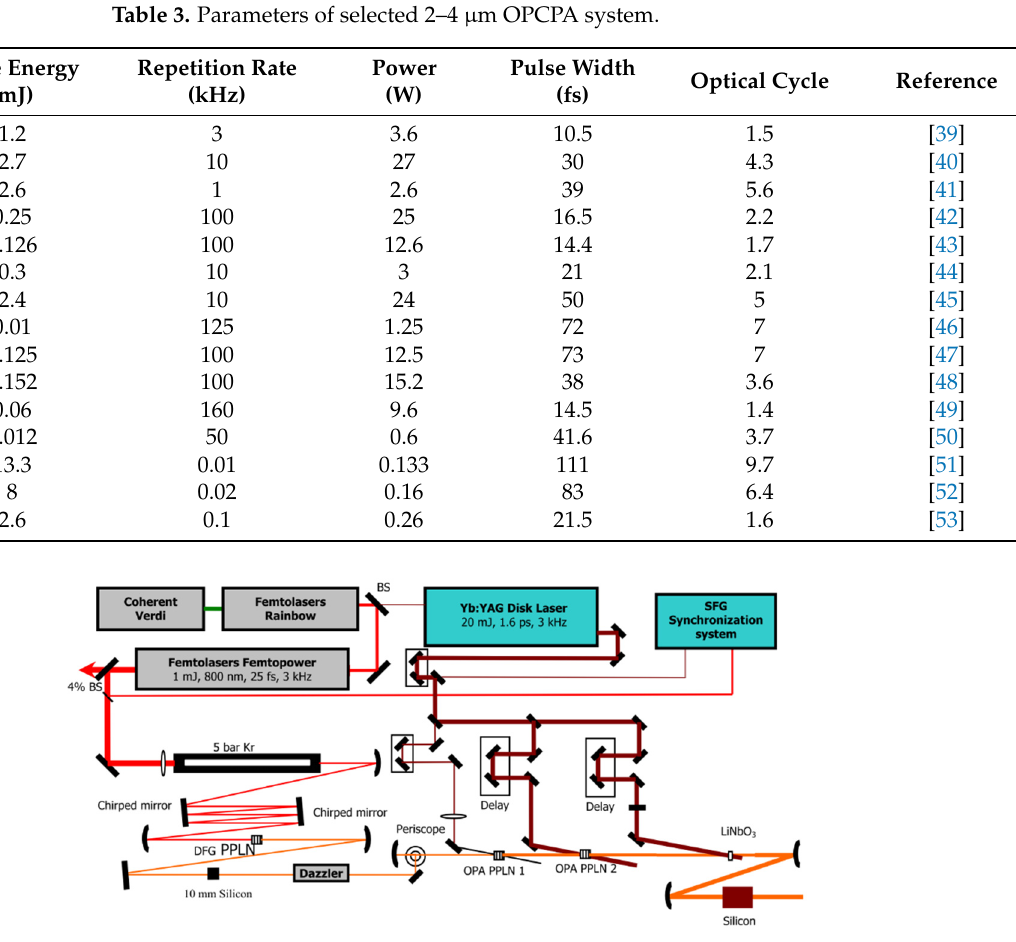
Figure 6. Schematic of 2.1 μ m few-cycle OPCPA system. Reprinted with permission from [39]. In 2020, U. Keller’s research group presented an OPCPA system centered at a wave- length of 2.2 µ m, generating 16.5 fs pulses (2.2 cycles) with 25 W of average power at 100 kHz [42]. As shown in Figure 7, the seed from a Ti:sapphire oscillator was amplified in a BBO crystal. The idler was then generated from the NOPA in another BBO. Through three NOPA stages, idler pulses were amplified to 300 µ J. Finally, after the compressor, pulses of 250 µ J and 16.5 fs were obtained. Based on the MIR OPCPA, soft-X ray emission with the spectrum extending to 0.6 keV was demonstrated.